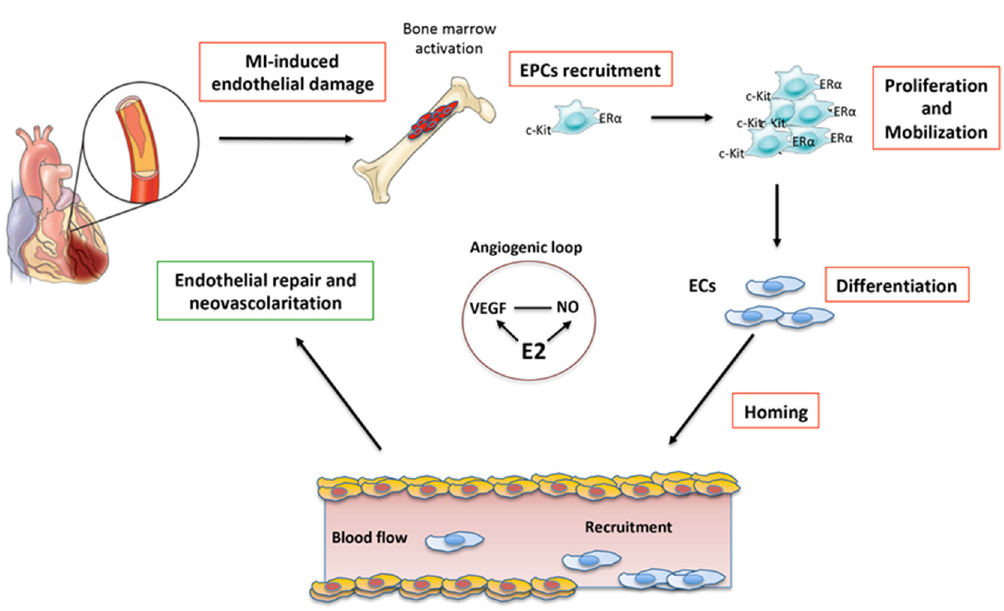
Figure 3. Schematic representation of the neovascularization following acute myocardial infarction (MI). E2 induces an angiogenic loop by stimulating VEGF and NO production. E2 also promotes proliferation, mobilization, homing, and differentiation of EPCs into ECs, thus, favoring the re-endothelialization and revascularization of the damaged myocardium. E2, estradiol; EPCs, endothelial progenitor cells; ECs, endothelial cells; NO, nitric oxide; VEGF, vascular endothelial growth factor; c-kit, type III receptor tyrosine kinase; ER α , estrogen receptor α . This cartoon was inspired by Nova-Lamperti et al., 2016 [74].